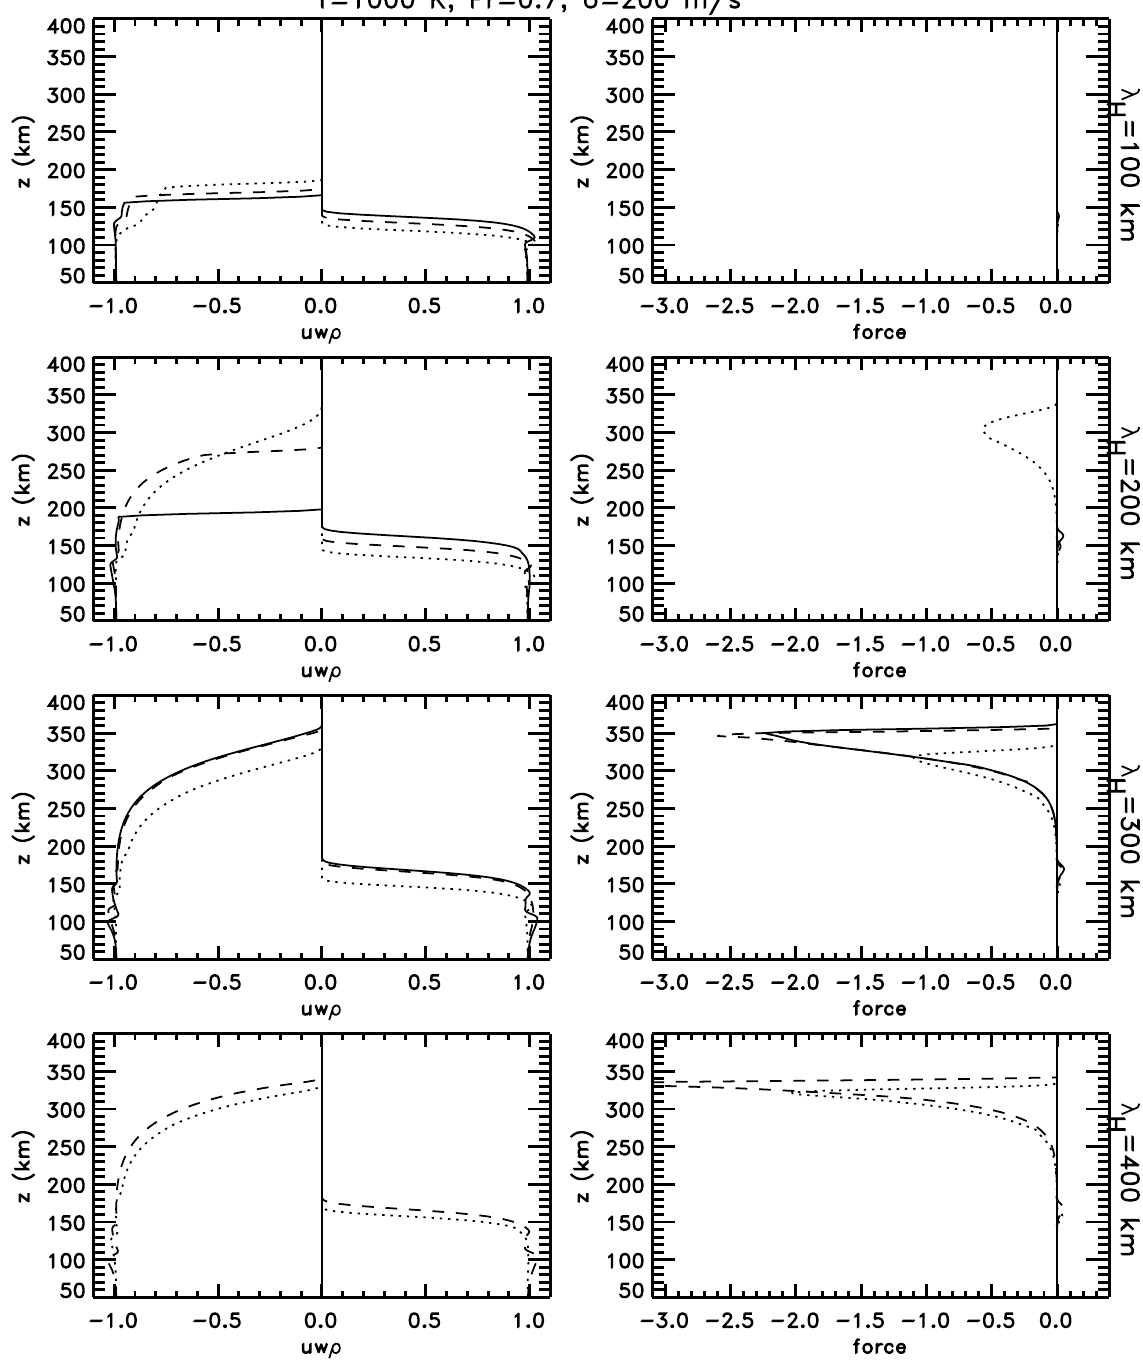
potential GW seeding of plasma instabilities, assuming these GWs arose from sources in the lower